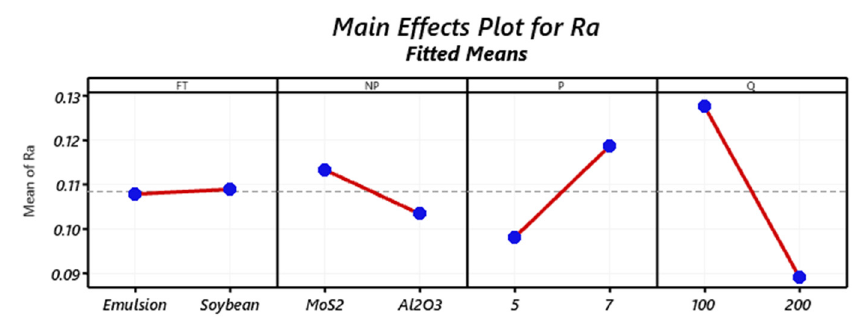
Figure 8. Main effects plot of input machining factors on surface roughness R a .